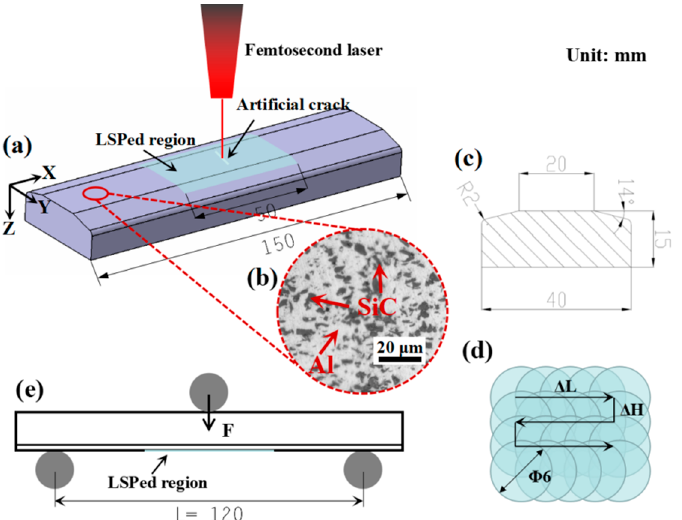
Figure 1. ( a ) Three-dimensional illustration of the preparation of 150 mm three-point bending fatigue specimens with the laser shock peened region indicated by light blue pattern and the artificial crack demonstrated by the white line; ( b ) optically observed microstructure of the SiCp/2009Al composite employed in this study, where the black irregulars are SiC particles and the rest are the 2009 aluminum substrate; ( c ) cross-sectional view of the three-point bending fatigue specimen including the detailed dimensions; ( d ) zigzag laser path illustrating an overlapping rate 40%; and ( e ) the experimental setup of the three-point bending fatigue test, where the support span is 120 mm.